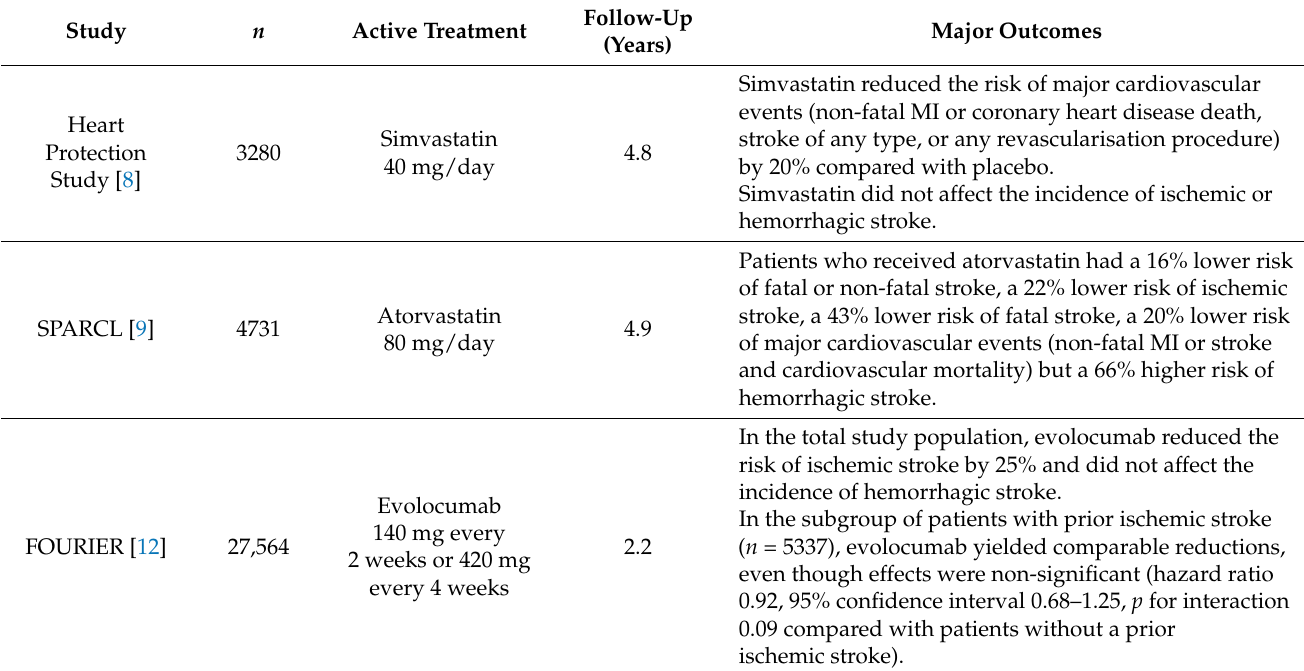
Table 1. Major multicentre, randomized, double-blind, placebo-controlled trials that evaluated the effects of lipid-lowering agents on the secondary prevention of ischemic stroke (MI: myocardial infarction; SPARCL: Stroke Prevention by Aggressive Reduction in Cholesterol Levels; FOURIER: Further Cardiovascular Outcomes Research with PCSK9 Inhibition in Subjects with Elevated